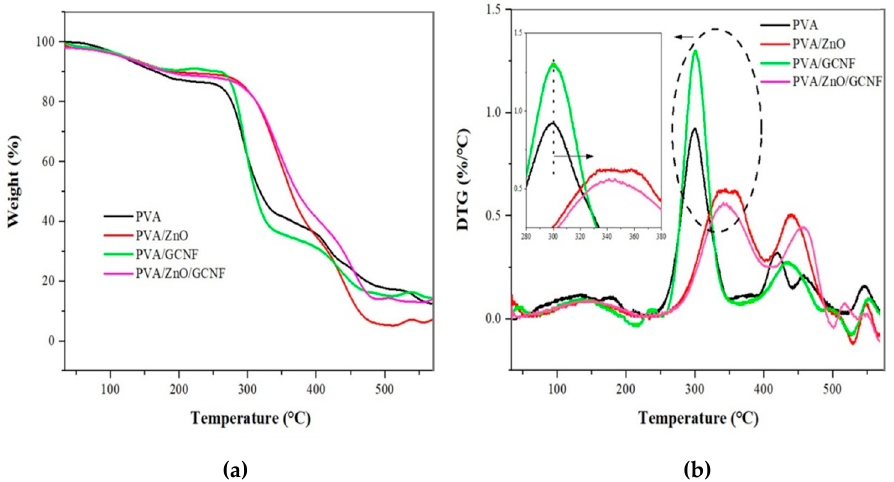
Figure 4. TGA ( a ) and DTG ( b ) curve for all samples.